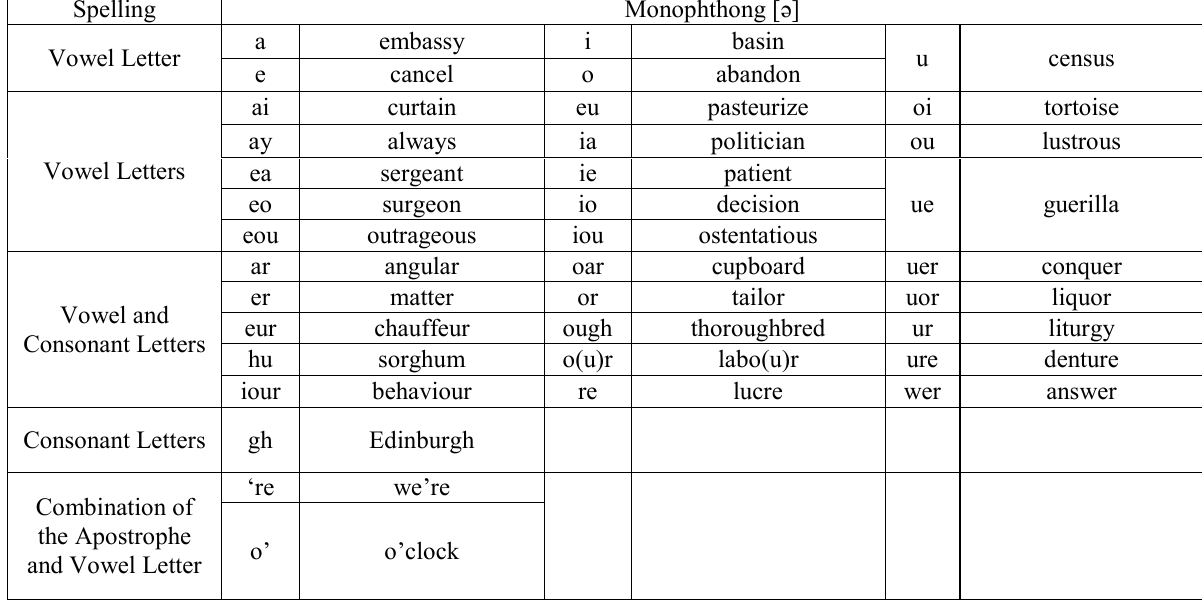
Table 4. Ways of Graphical Spelling of Monophthong [ ə ]